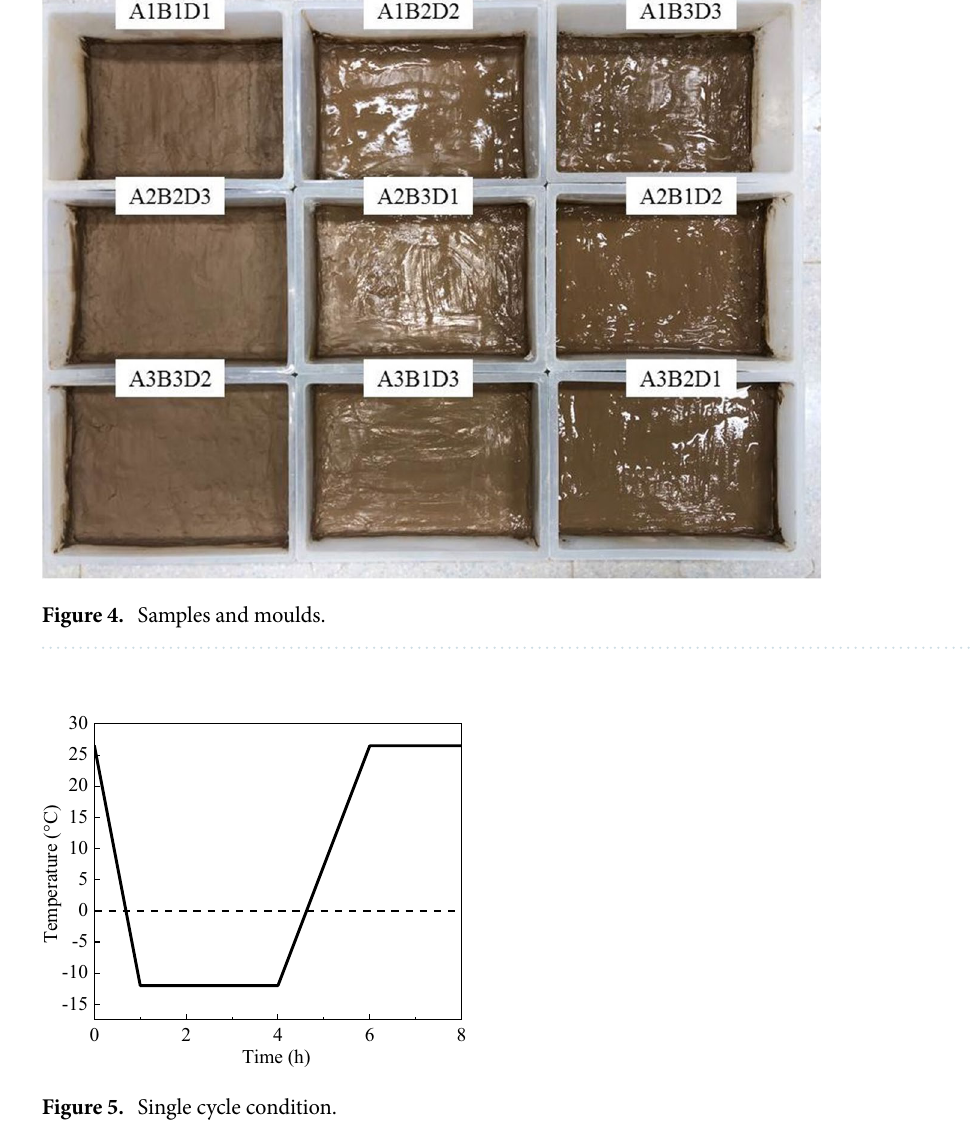
Figure 5. Single cycle condition.